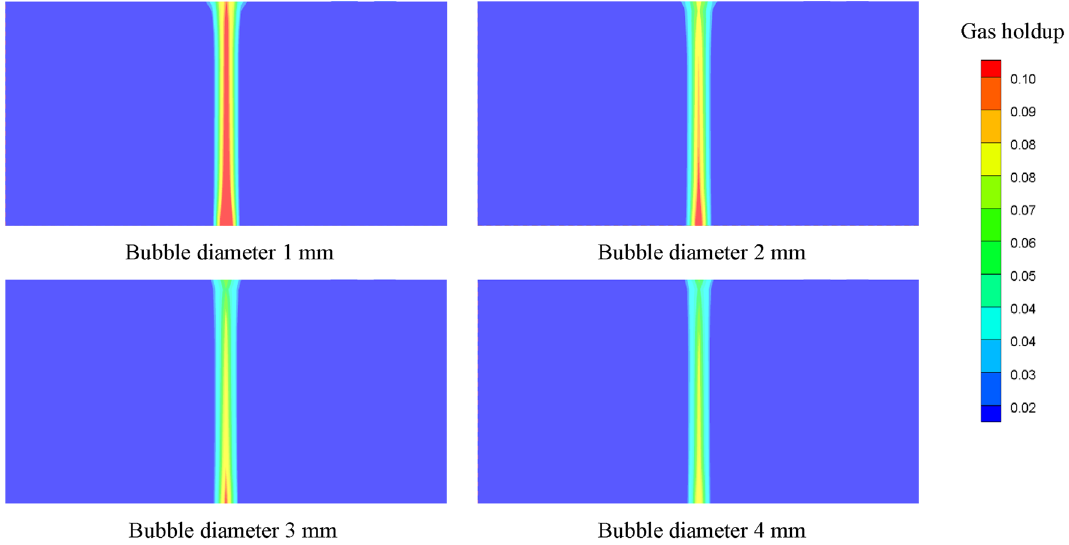
Figure 7. Gas holdup distributions at different bubble